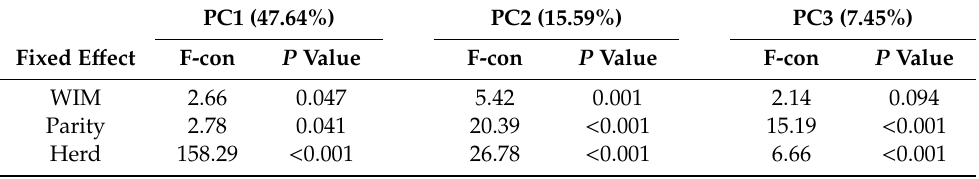
Table 2. Results of multiple linear regression models of principal component (PC) scores derived from PCA of 1 H NMR spectra, against weeks in milk (WIM), parity, and herd of origin. Conditional Wald F statistics (F-con) and corresponding P values describe the magnitude and statistical significance of each fixed e ff ect,